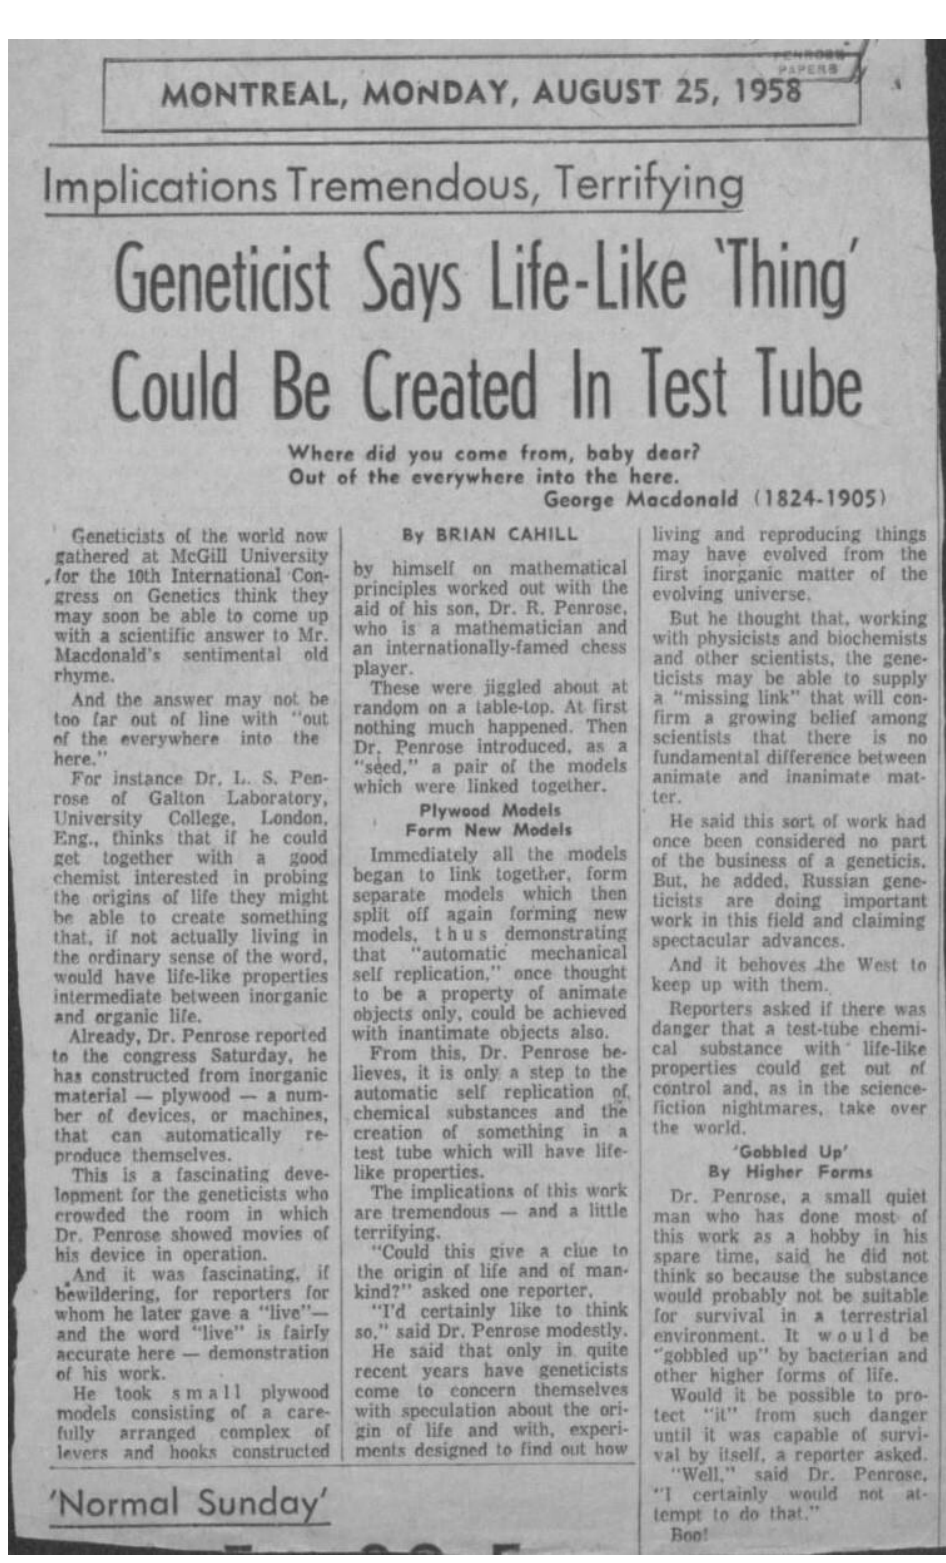
Figure 2. Coverage of the Lionel Penrose presentation at the MacGill University conference by the journalist Brian Cahill for the local Newspaper “Montreal Star” .